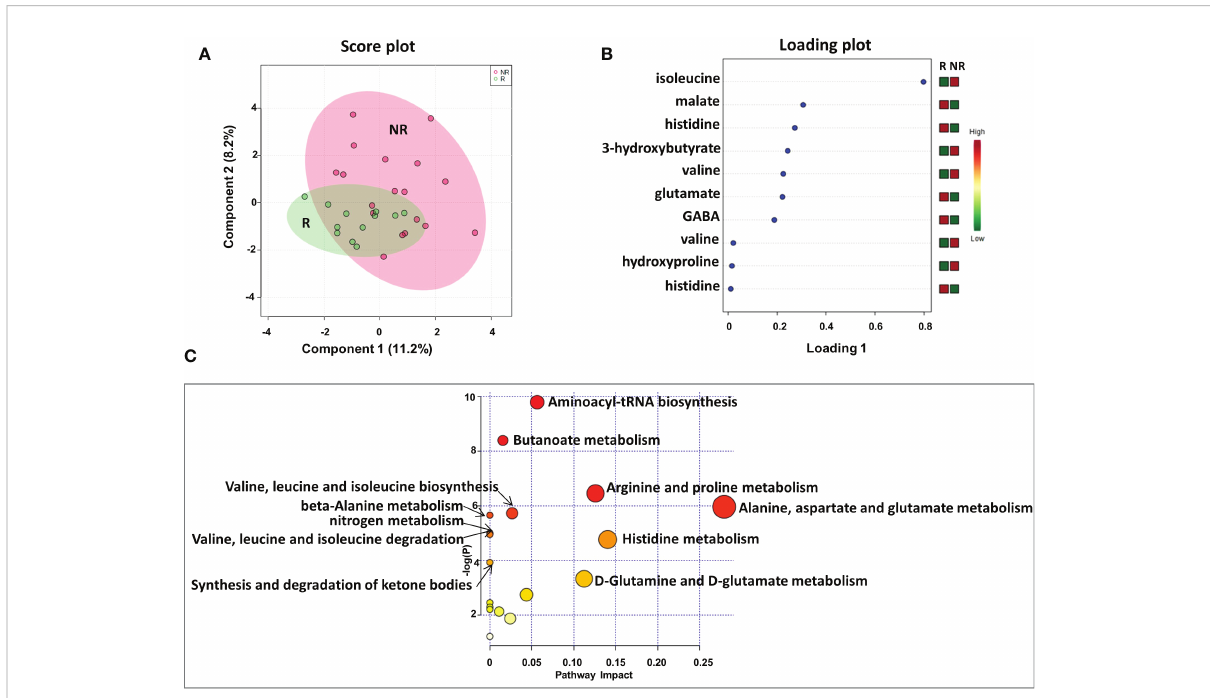
FIGURE 2 Score plot (A) and loading plot (B) related to metabolomic pro fi ling on plasma of mCRC patients, collected at response evaluation when liver resectability was established and subdivided accordingly to DFS in good (R; DFS ≥ 1 year) and bad (NR; DFS < 1 year) responders. (C) The most signi fi cant pathways are reported: colors, from yellow to red, indicate increasing levels of statistically signi fi cance (p values from the pathway enrichment analysis); size of the nodes indicates pathway impact (a combination of both pathway enrichment results and centrality of each of the matched metabolites within the